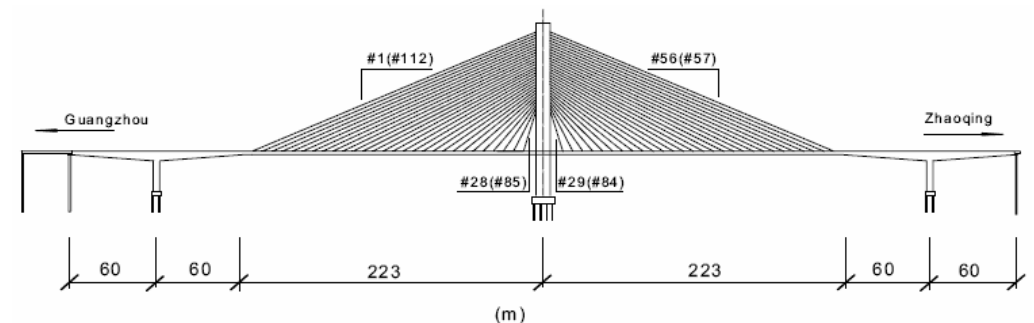
Fig. 5. (a) View of the Jinma cable-stayed bridge; (b) Elevation